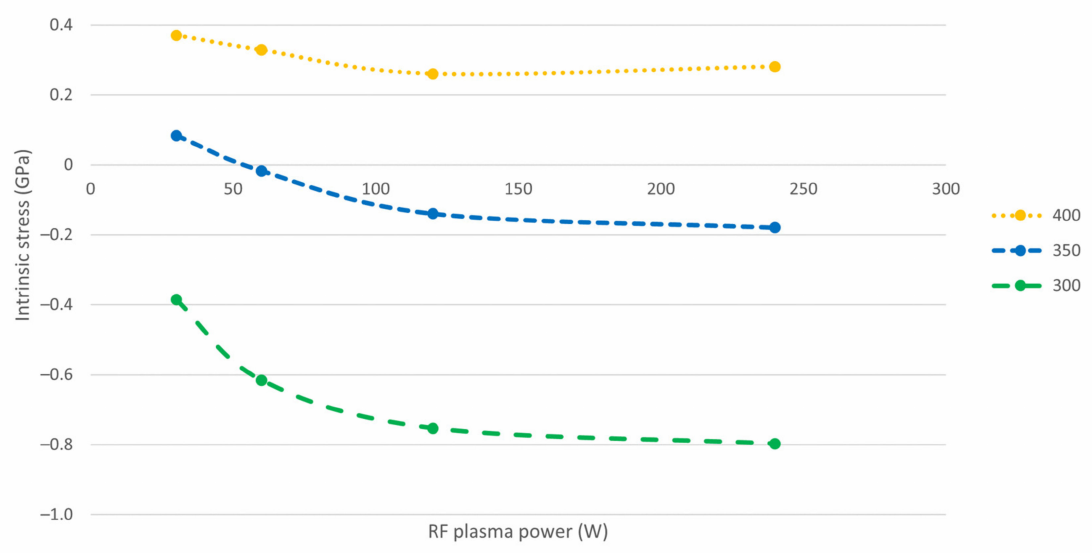
Figure 2. Intrinsic stress in PECVD boron thin films deposited at different temperatures and RF plasma